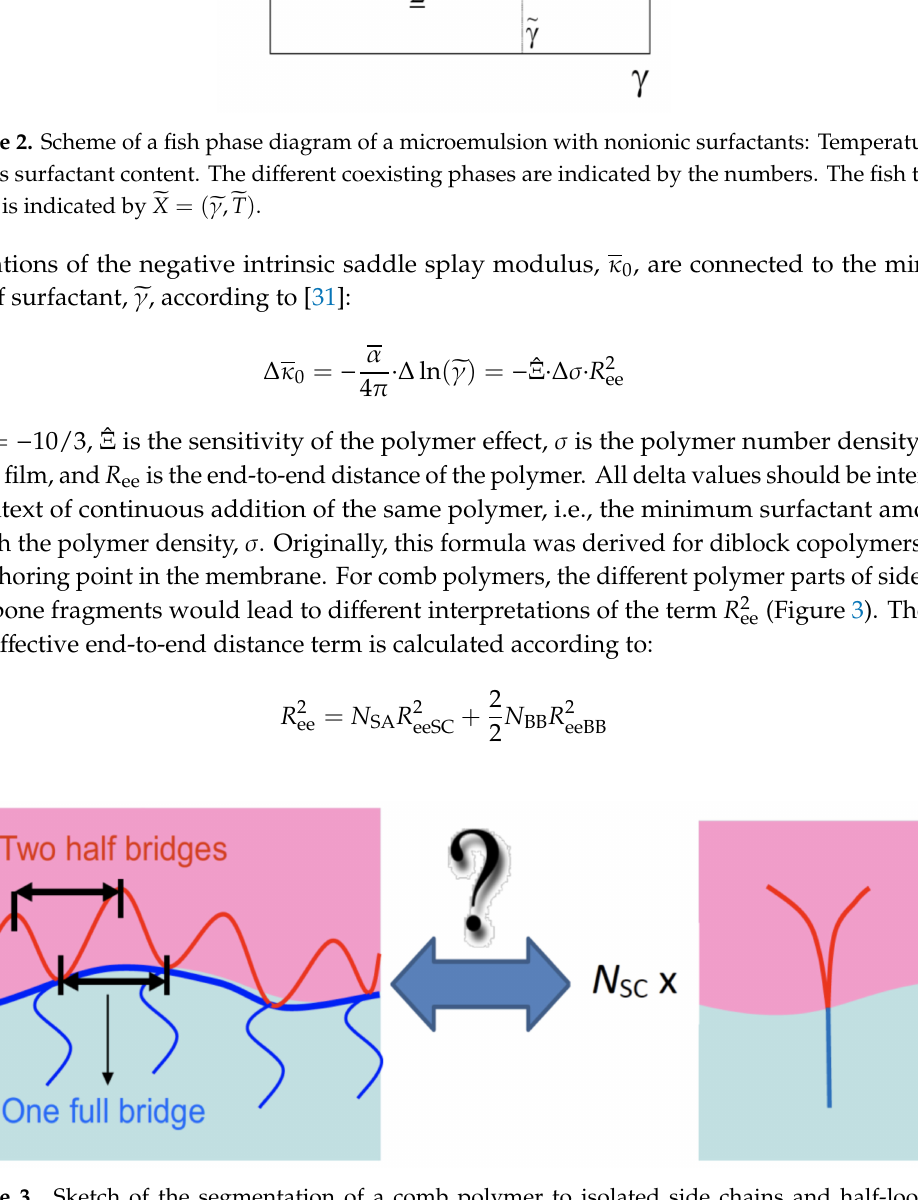
Figure 3. Sketch of the segmentation of a comb polymer to isolated side chains and half-loops. The backbone fragments as bridges are interpreted as